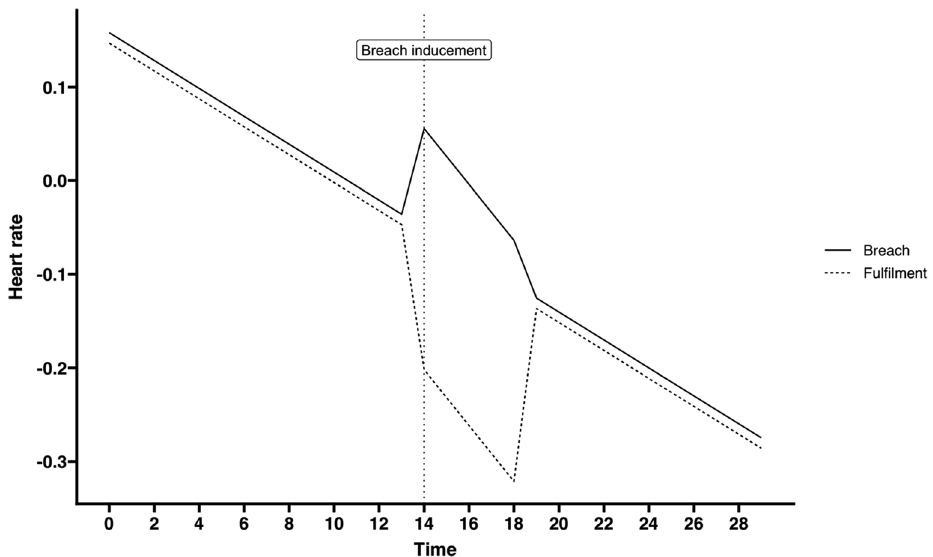
Figure 2. HR trajectories based on Model 1d for breach and fulfillment